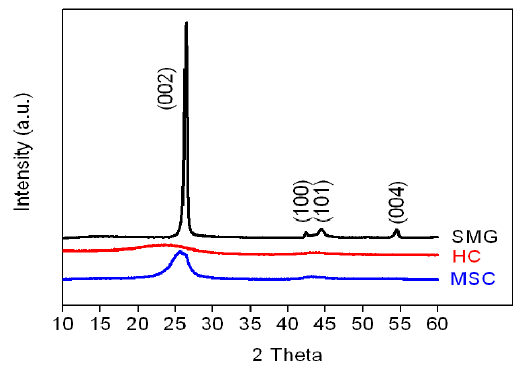
Figure 2. XRD patterns of SMG, HC, and MSC anode materials.